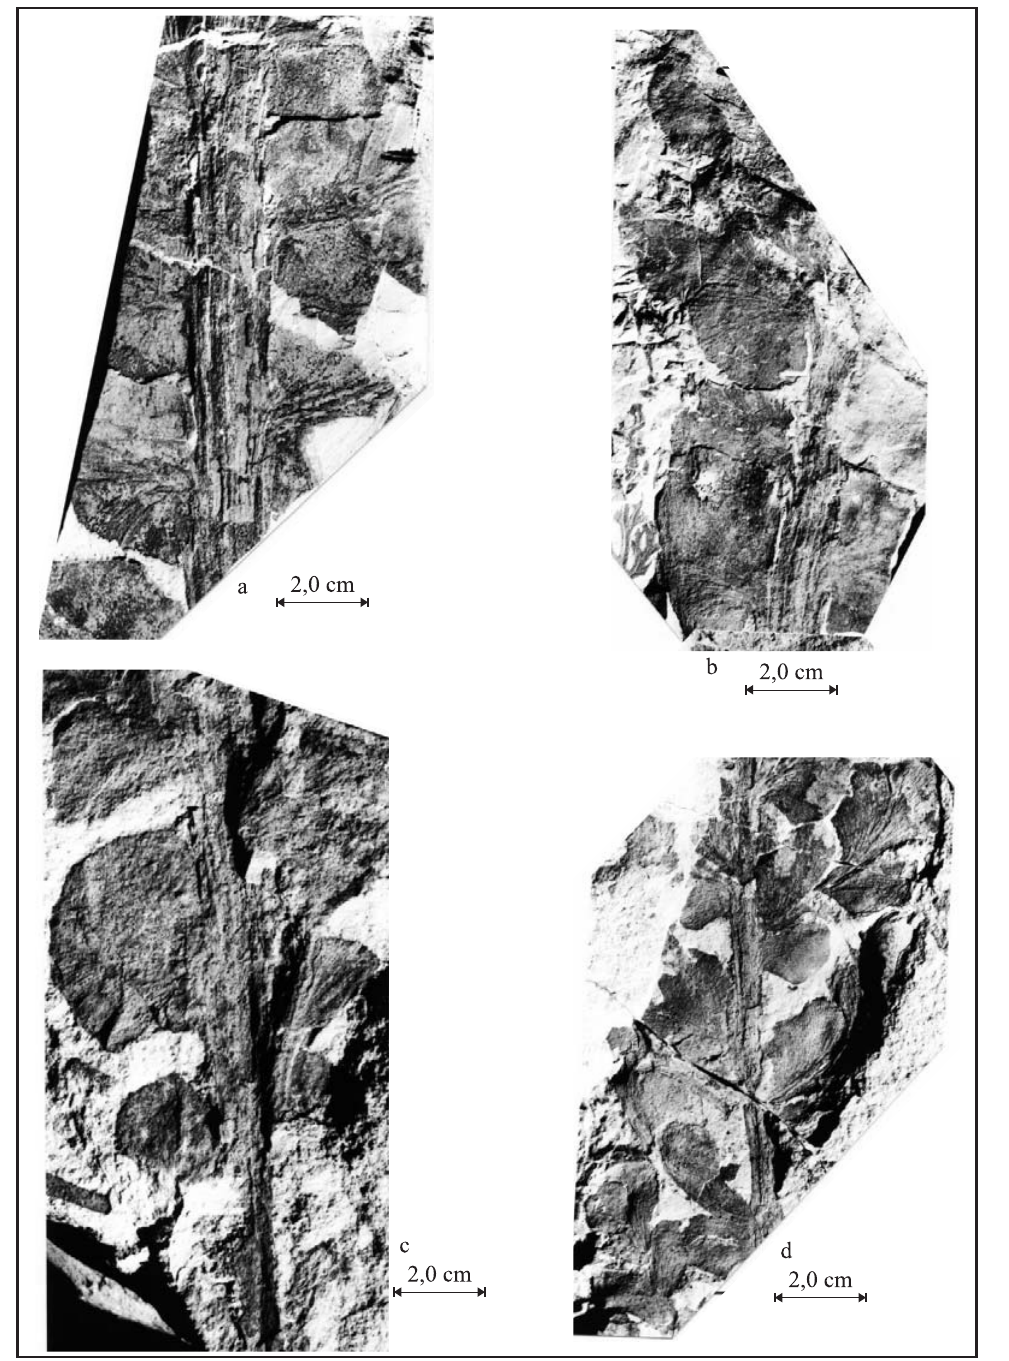
Fig. 5 – Botrychiopsis valida .fronds from Quitéria (a) detail of the middle portion of a frond with pines and it insertion in the rachis – PbU 0281; (b) middle portion of the frond with complete limbus presenting small insertions and venation – PbU 0233; (c) basal portion of the frond with the insertion of the pines – PbU 0062; (d) apical portion of the frond with pines presenting a complete limbus with insertions and venation – PbU